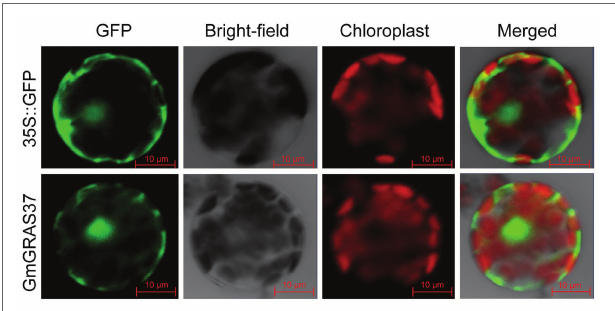
FIGURE 11 | Subcellular localization of GmGRAS37-16318hGFP fusion protein. 35S::GFP was used as a control. The scale bar indicates 10 μ